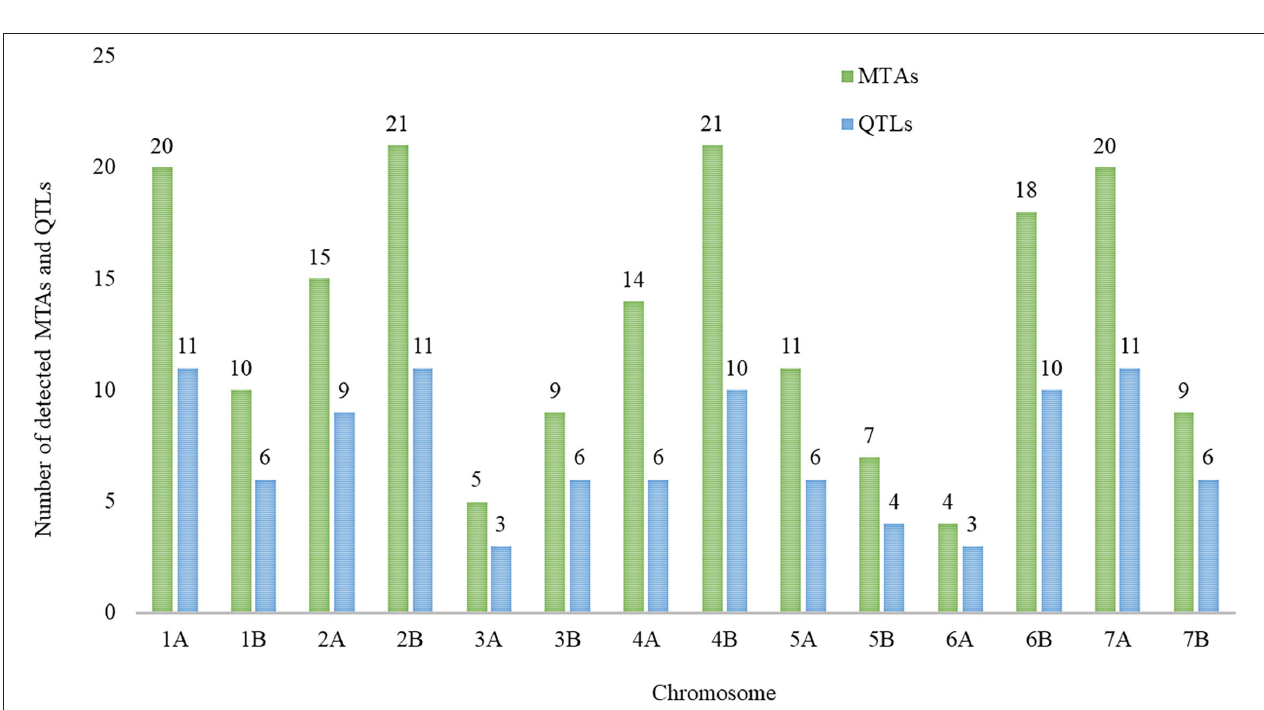
FIGURE 5 | The number of detected marker-trait associations (MTAs) and quantitative trait loci (QTLs) that were detected for drought indices across the durum wheat genome.